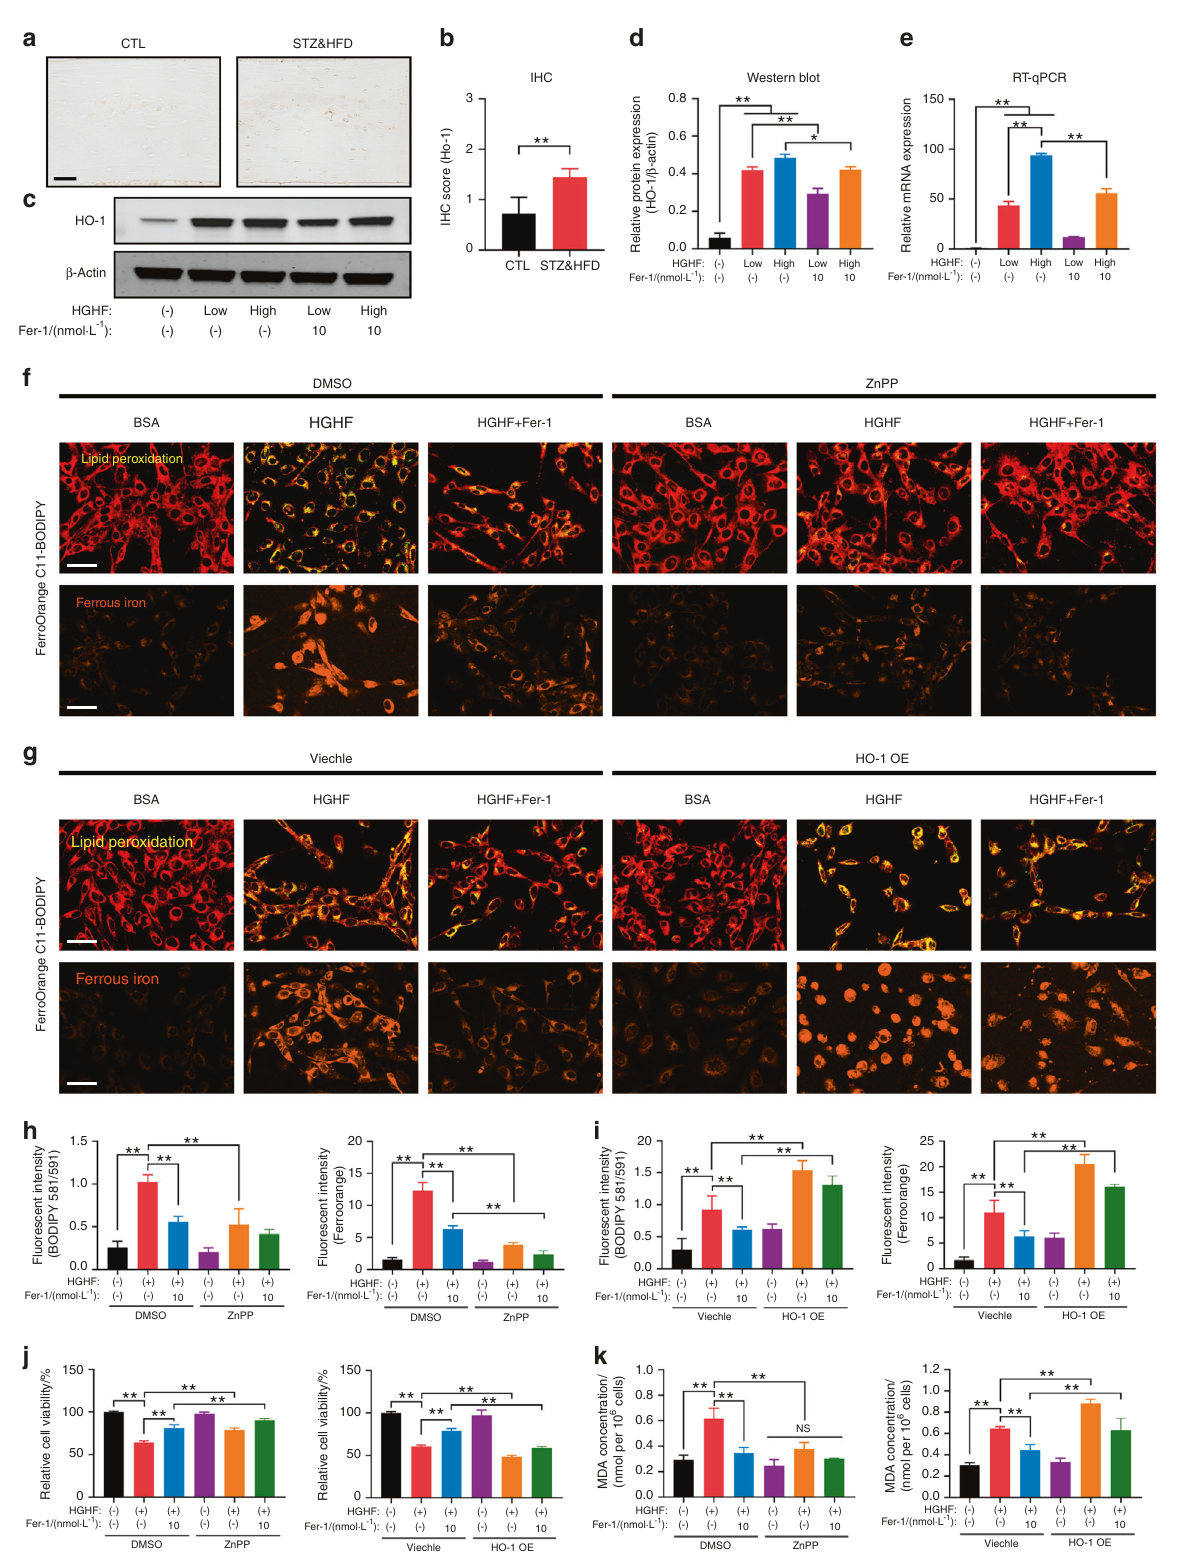
Fig. 4 HO-1 was essential for HGHF-induced ferroptosis. a Representative images of HO-1-stained bone sections from CTL mice and STZ&HFD mice (scale bar: 50 μ m). b Quanti fi cation of HO-1 expression in vivo. c Western blot showing HO-1 expression under various treatments. d Quanti fi cation of HO-1 expression based on WB analysis. e RT – qPCR showing HO-1 expression under various treatments. The β -actin gene was used as the internal reference gene. C11-BODIPY (scale bar: 100 μ m) and FerroOrange (scale bar: 100 μ m) staining of ZnPP-treated osteocytes ( f ) and HO-1-overexpressing osteocytes ( g ). h , i Quanti fi cation of fl uorescence intensity. j Osteocyte viability was assessed by a CCK-8 assay. k The MDA concentration was assessed using an MDA assay kit. ** P <0.01. “ NS ” indicates nonsigni fi cant. All data are from n = 3 independent